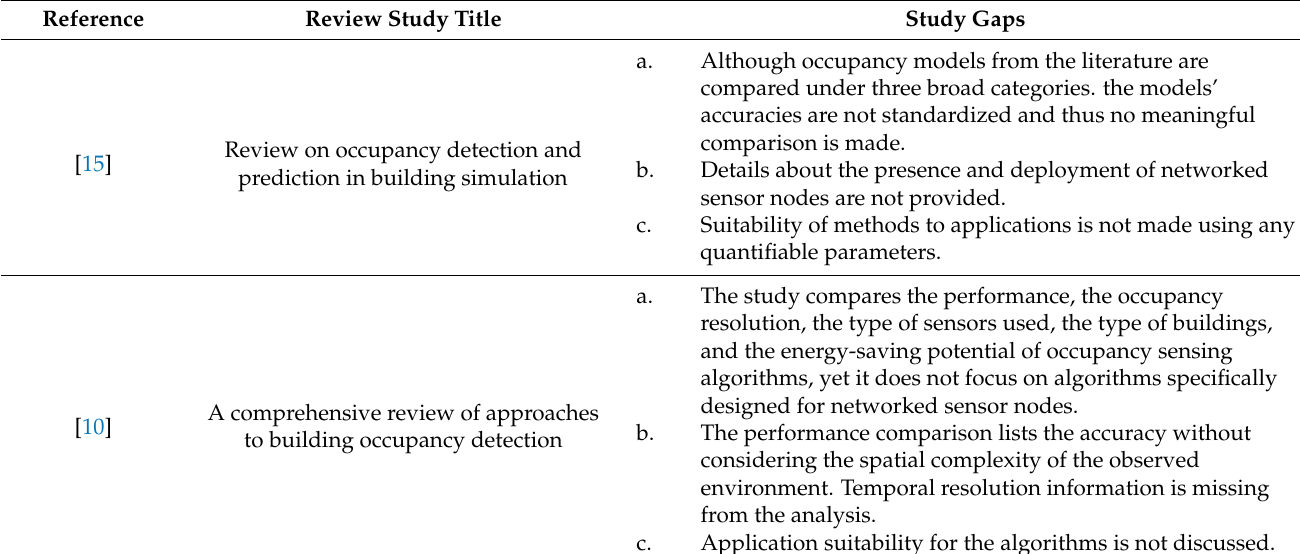
Table 1. Contribution and gaps for contemporary occupancy sensing review studies involving networked sensor nodes.